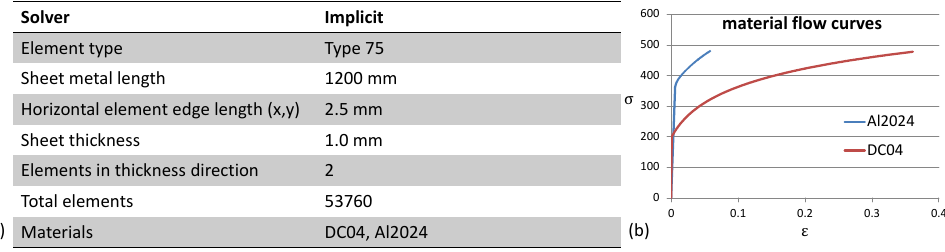
Figure 5. ( a ) Mesh properties and ( b ) material flow curves of DC04 and Al2024.